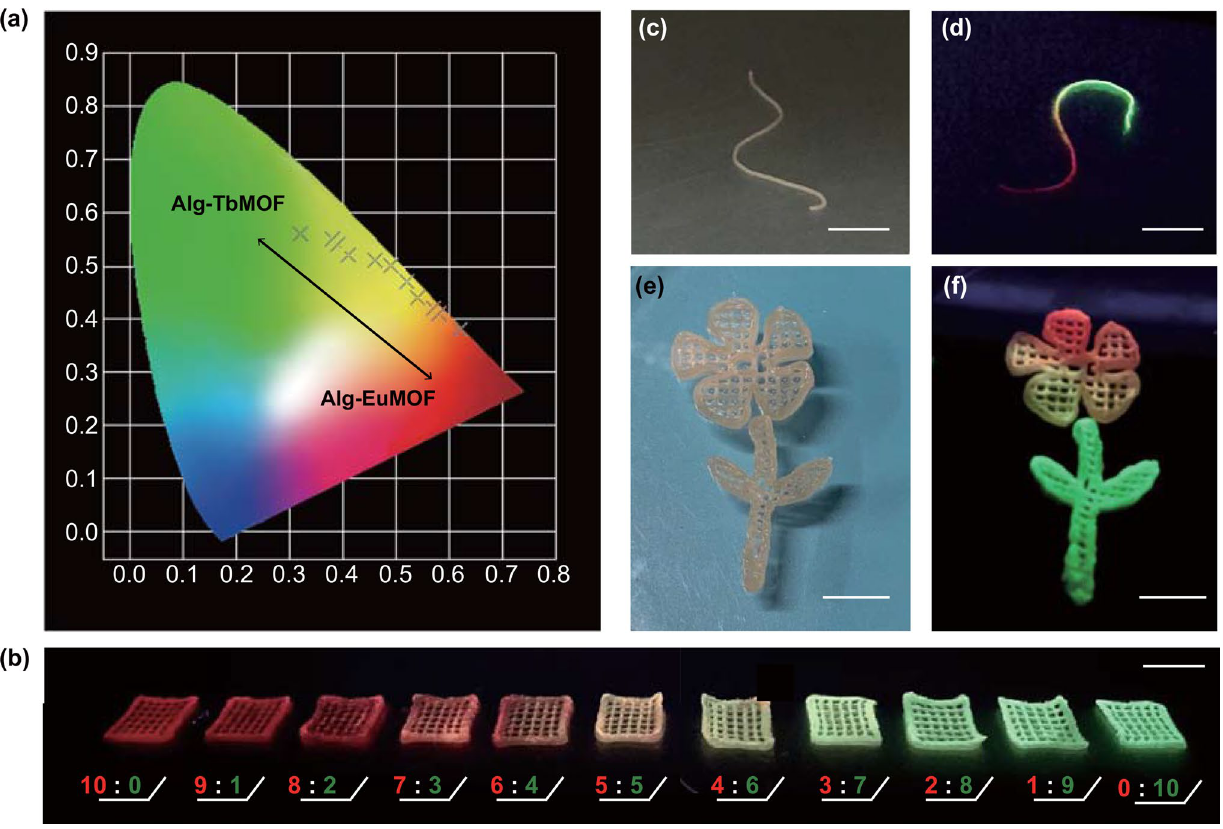
Fig. 4 Post-printing treatment of 3D-printed constructs in the mixed lanthanide ions solution. a CIE 1931 chromaticity diagram for Alg-TbMOF and Alg-EuMOF and mixed metal Alg-Eu/TbMOF (from left to right: Eu 3+ /Tb 3+ = 10:0, 9:1, 8:2, 7:3, 6:4, 5:5, 4:6, 3:7, 2:8, 1:9, 0:10) and b the corresponding luminescent images of 3D-printed constructs under UV irradiation ( λ exc = 254 nm). c – f Photographs of filament and 3D-printed flower-like structure that can be post-designed with tunable fluorescence in different positions originating from mixed lanthanide ions. Scale bars are 1